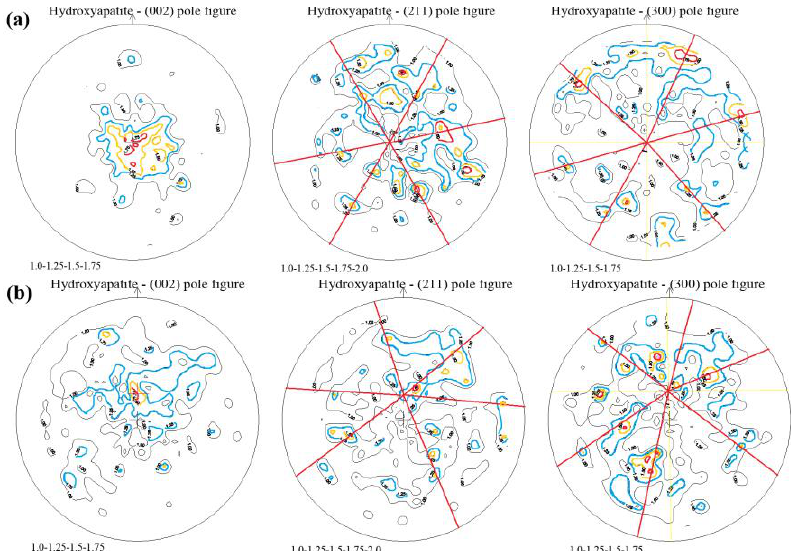
Figure 10. X-ray pole figures of hydroxyapatite: ( a ) (002), (300) and (211) pole figures of hydroxyapatite in ivory, ( b ) the same in mammoth ivory.